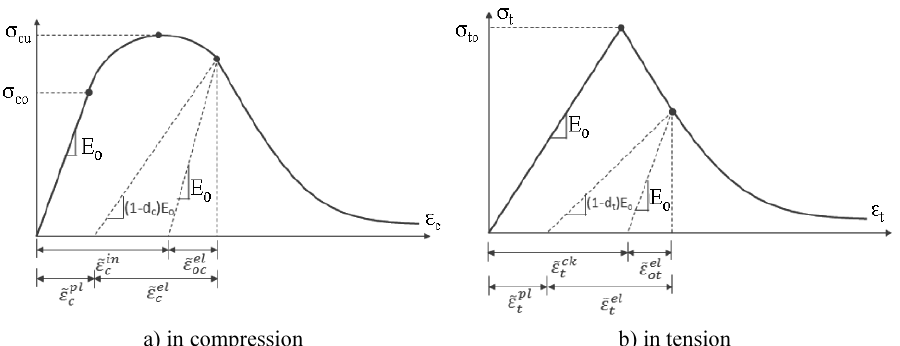
Fig. 3. CDP model of concrete both in compression and tension (ABAQUS User Manuel 2009)